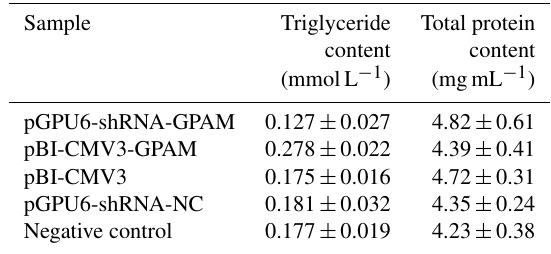
Table 2. The TG and total protein contents of each transfected group in